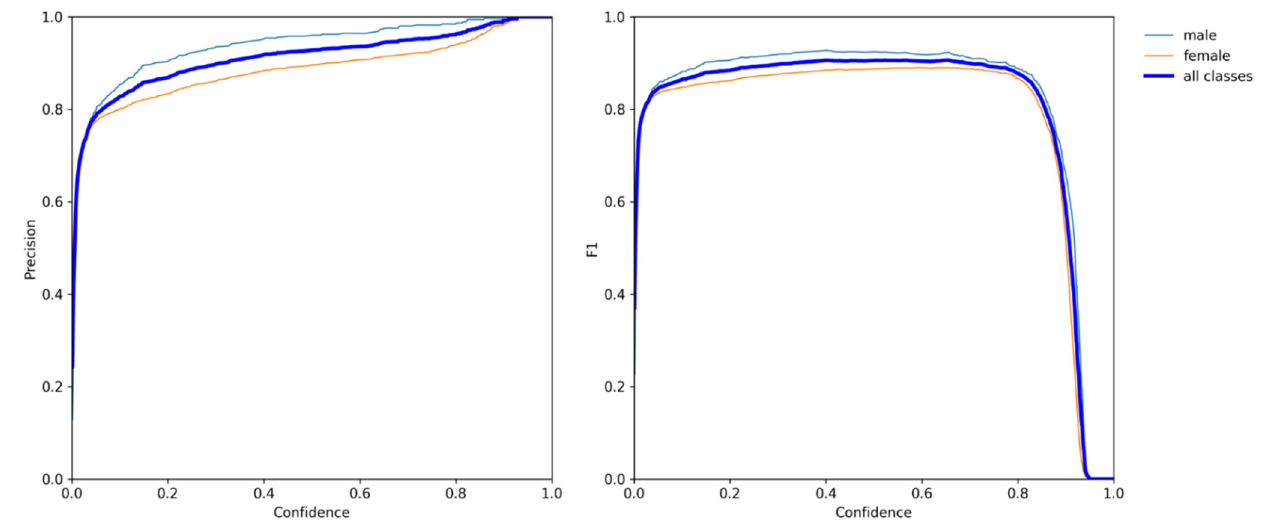
Figure 10. The relationship between precision, F1 score, and confidence of the model in classifying the ducks as male and female.